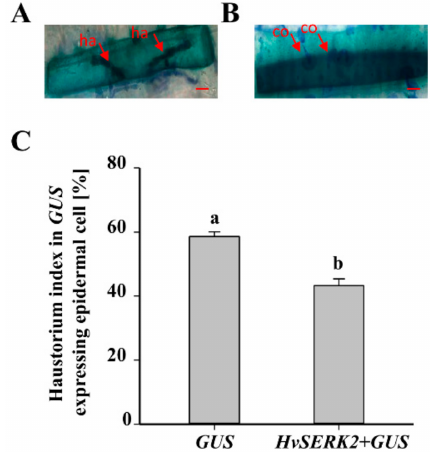
Figure 7. Functional analysis of HvSERK2 by single-cell transient overexpression assay. ( A ) Bgh conidia successfully penetrated epidermal cells co-expressing GUS and HvSERK2 with haustorium; ( B ) Bgh conidia failed to penetrate epidermal cells co-expressing GUS and HvSERK2 . Bars in ( A , B ) = 20 µ m; ( C ) in comparison with transforming GUS alone, the haustorium index of the cells co-transformed with GUS and HvSERK2 significantly decreased. ha: haustorium; co: conidium. Bars with different letters show significant differences at the level of p <